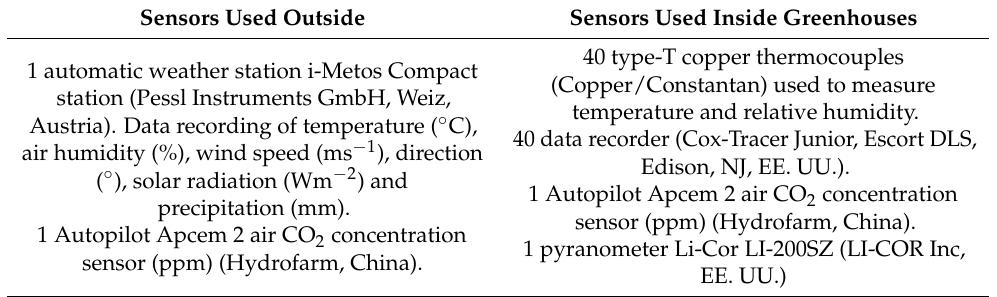
Table 6. Climate monitoring sensors used in the microclimatic characterization of the 5 green- houses.